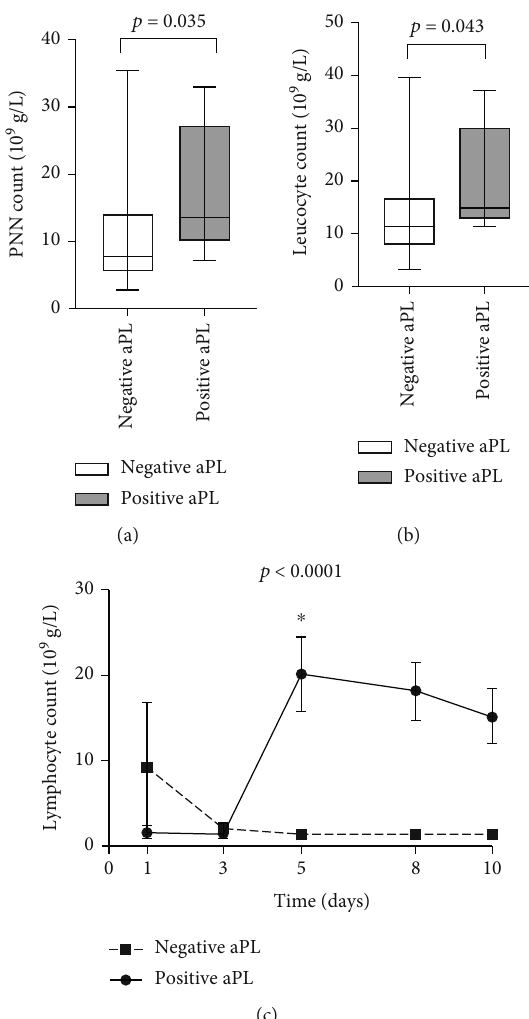
Figure 5: (a) Polynuclear neutrophil (PNN) cell count at day 5. (b) Leucocyte cell count at day 5. (c) Evolution of lymphocyte count from day 1 to day 10 in positive and negative aPL patients. Data are means ± SEM